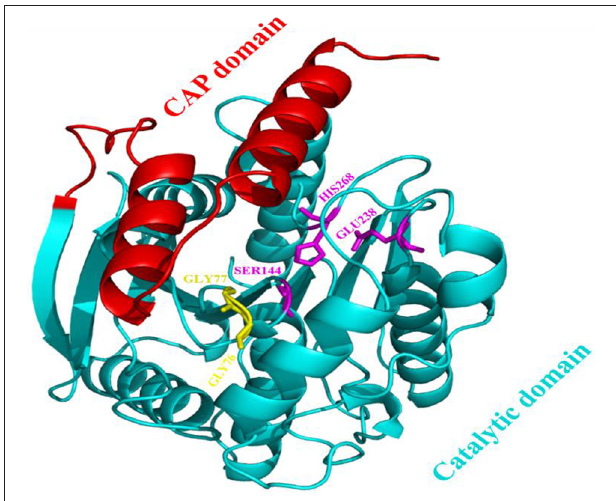
FIGURE 4 | Domain architecture of the 7N9 esterase. The CAP domain is highlighted in red, the catalytic triad Ser144, Glu238, and His268 is highlighted in magenta, the oxyanion hole comprising of residues Gly76 and Gly77 is highlighted in yellow, the catalytic domain is highlighted in light blue.